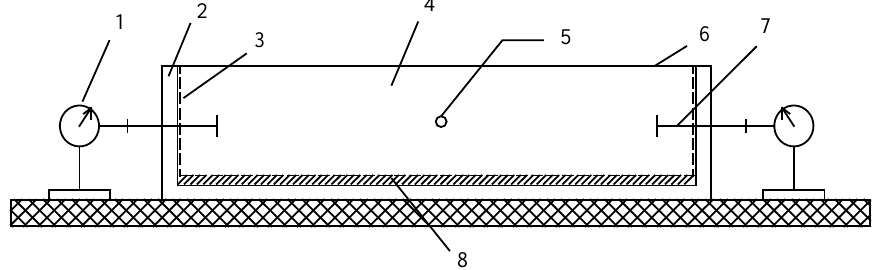
Figure 2. Illustration of the device for free shrinkage test before 1 d: (1) Digital dial gauge; (2) Dismountable mold; (3) Foamed plastic sheet; (4) Concrete specimen; (5) Thermal couple; (6) Plastic film; (7) Gauge studs; (8) 0.5mm-thick Teflon sheet.